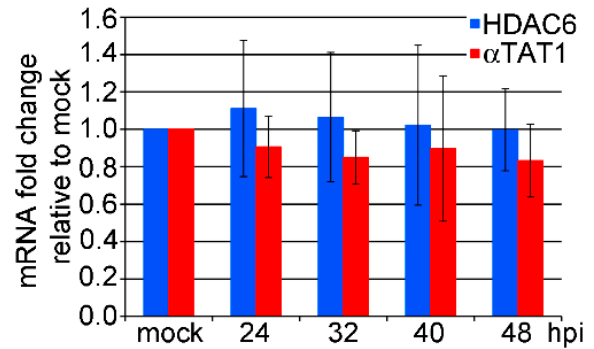
Figure 2. VP1 expression does not change the mRNA levels of either α -tubulin acetyltransferase 1 ( α TAT1) or histone deacetylase 6 (HDAC6). 3T6 cells were infected, and the levels of HDAC6 or α